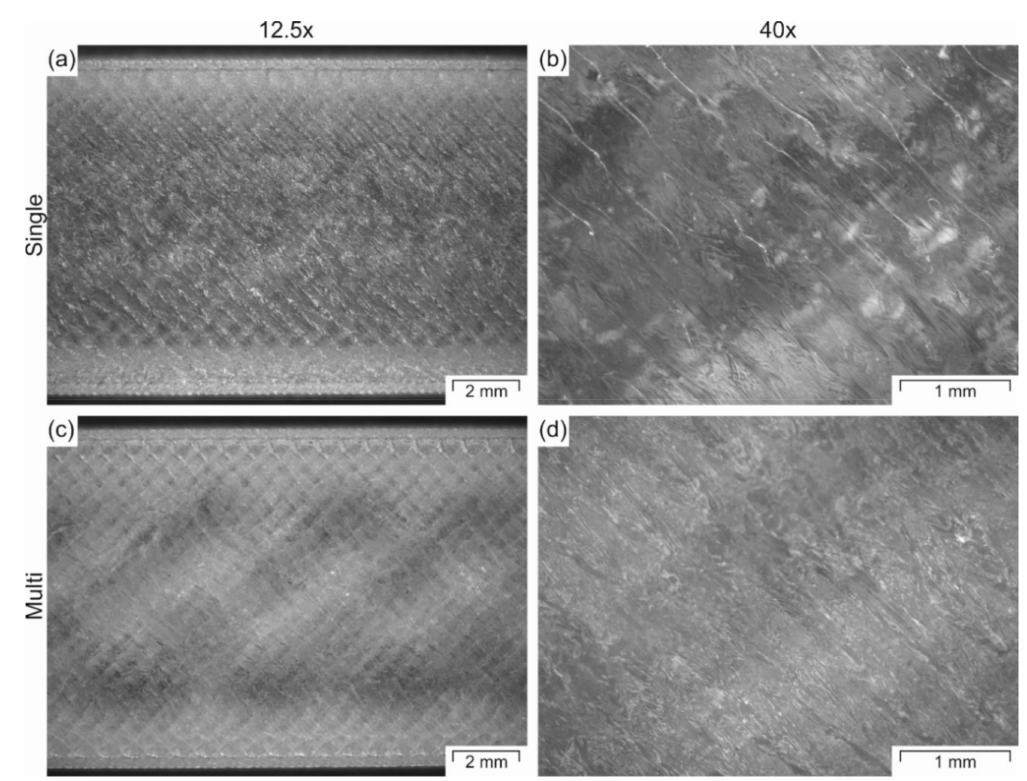
Figure 12. Microscopy images of tensile specimens printed in ( a , b ) batch of one specimen (Single) or ( c , d ) five specimens (Multi) recorded at two di ff erent magnifications (12.5 and 40). All images were taken from the top view and laying the specimens in the XY-plane.